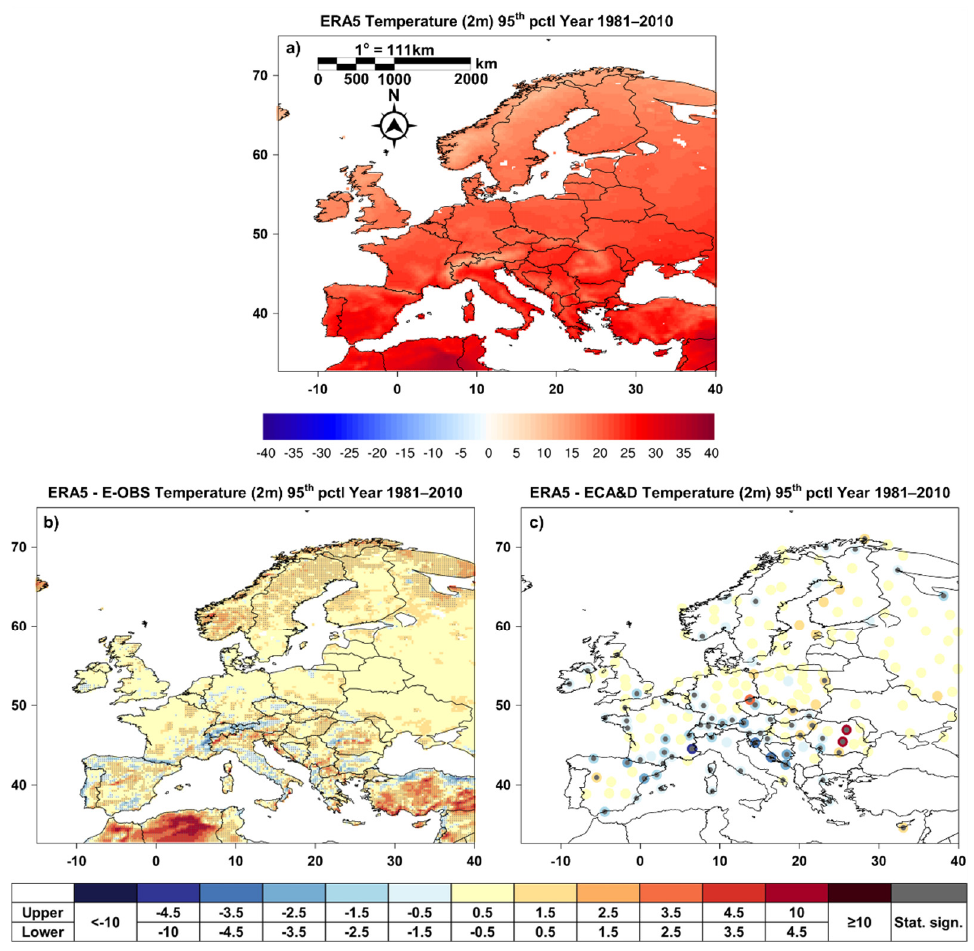
Figure 6. Extreme high mean temperature (°C) (95th percentile) for ( a ) ERA5, and the differences between ( b ) ERA5 and E-OBS, and ( c ) ERA5 and ECA&D stations.